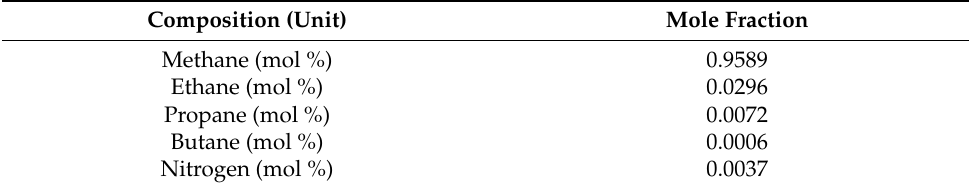
Table 1. Chemical composition of LNG. Composition (Unit) Mole Fraction